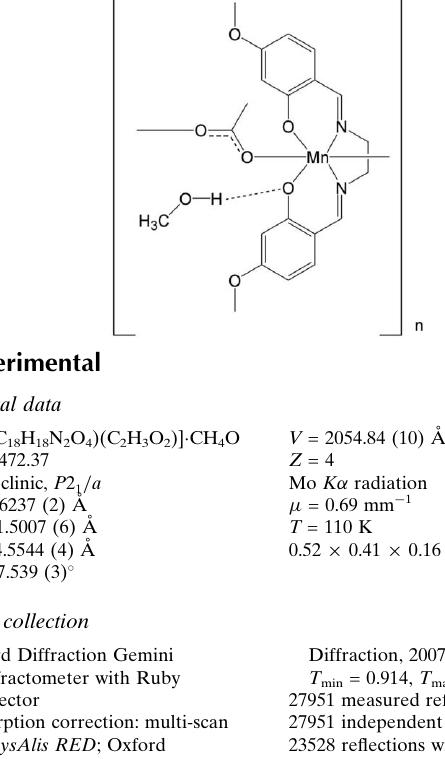
Data collection Oxford Diffraction Gemini diffractometer with Ruby detector Absorption correction: multi-scan ( CrysAlis RED ; Oxford